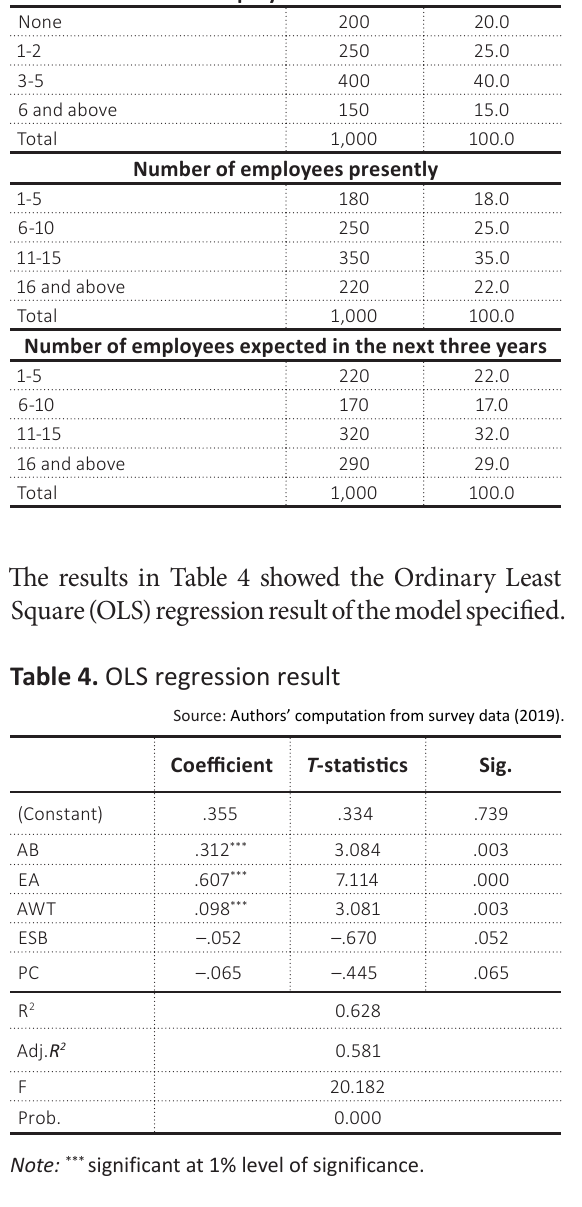
Table 2. Profitability characteristics of enterprises surveyed